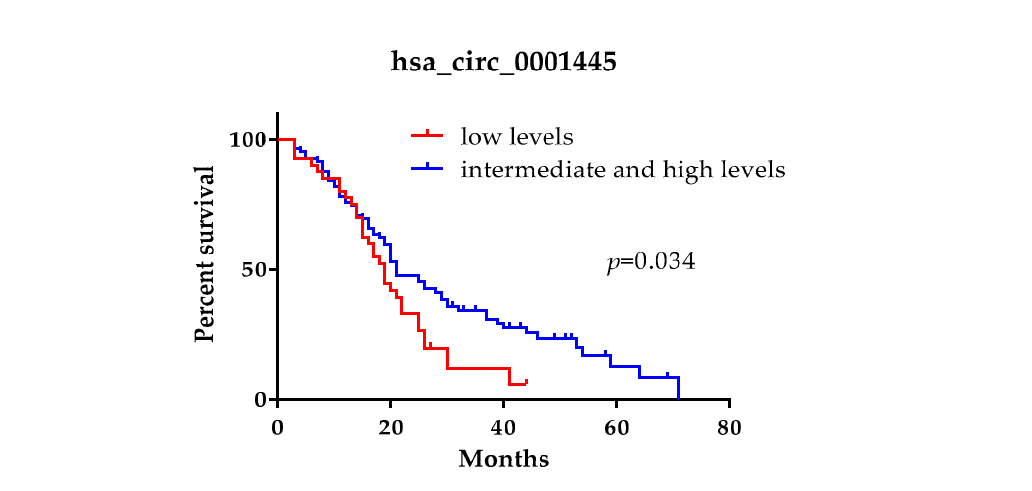
Figure 4. Kaplan–Meier survival analysis for assessment of hsa_circ_0001445 levels and the overall survival of CRC patients in stage IV. Overall survival of patients with intermediate and high levels of hsa_circ_0001445 was compared to overall survival of patients with low levels of the circRNAs. Table 3. Results of Cox regression analysis for predicting overall After each variable was separately entered in a Cox’s model, the variables that had a